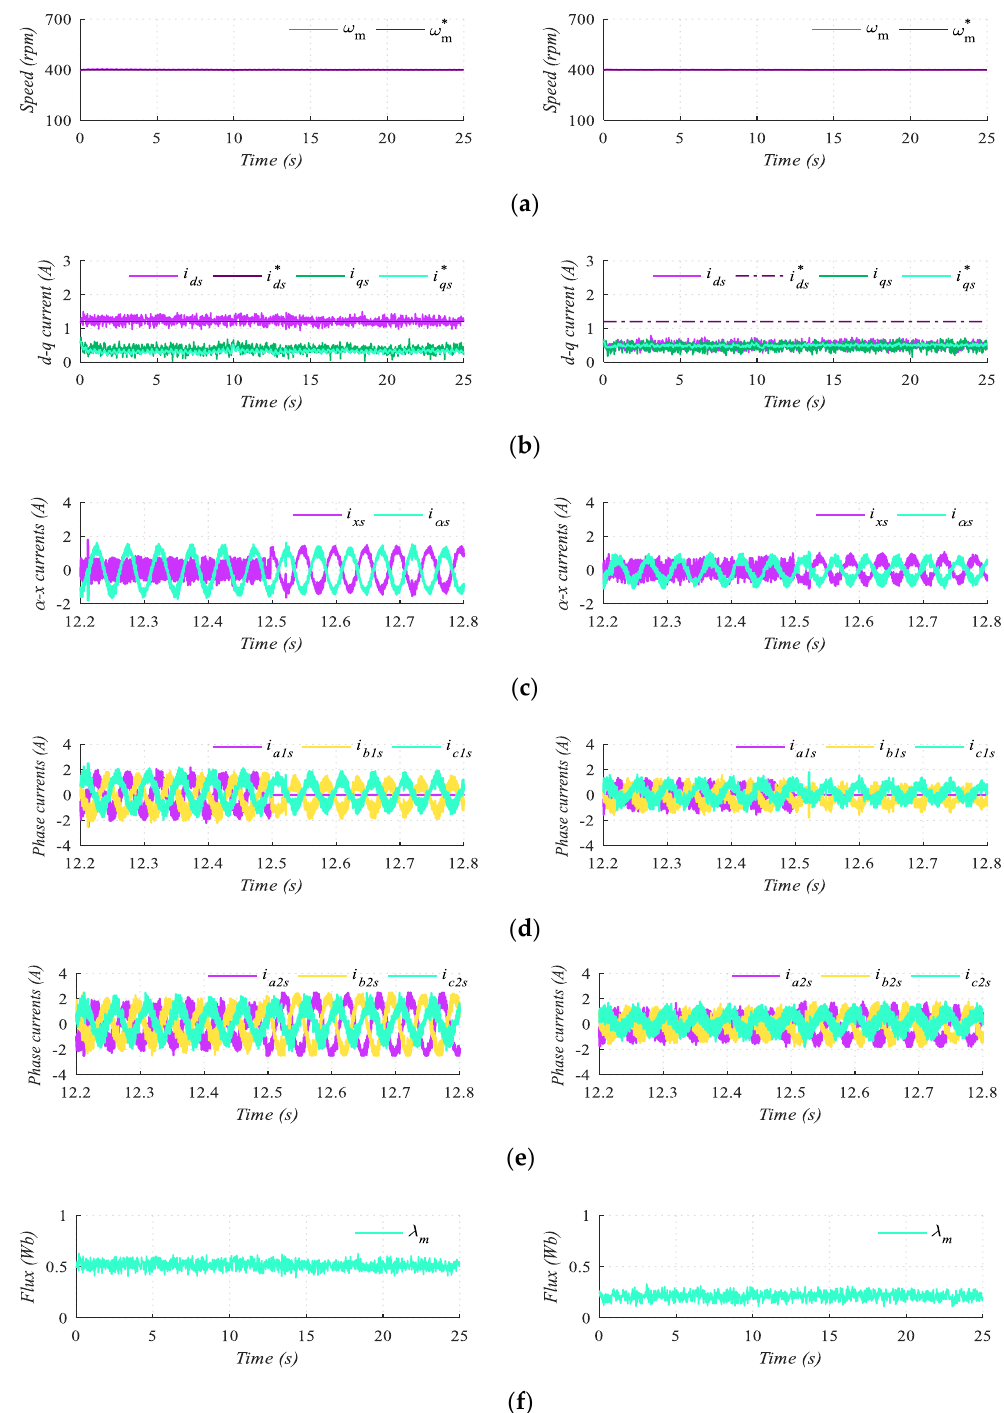
Figure 8. Trasition from pre to post-fault situations using VV-MPC (left column) and the proposed EVV-MPC (right column) control methods. From top to bottom: ( a ) Motor speed; ( b ) 𝑑 - 𝑞 currents; ( c ) 𝑥 - 𝛼 currents; ( d ) set 1 of phase currents ( e ) set 2 of phase currents; and ( f ) stator magnetic flux.